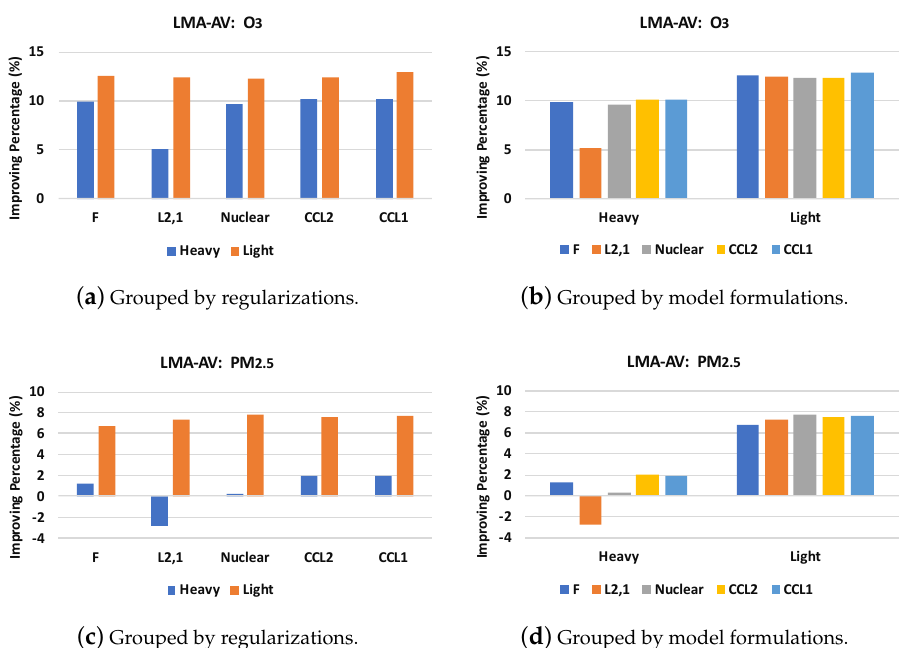
( d ) Grouped by model formulations. Figure 3. Improvement of different methods over the baseline method for Lansing Municipal Airport–Alsip Village (LMA–AV)